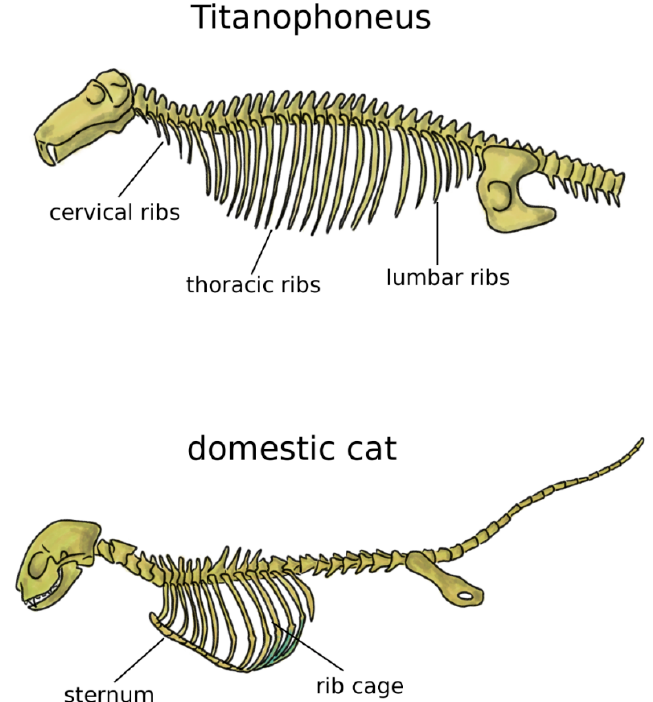
Figure 3. Axial skeleton of a reptile, the extinct Titanophoneus (top, tail not completely shown) and a mammal, Felis catus (bottom), highlighting the presence of cervical, thoracic, and lumbar ribs in the former, and of the rib cage and sternum in the latter.